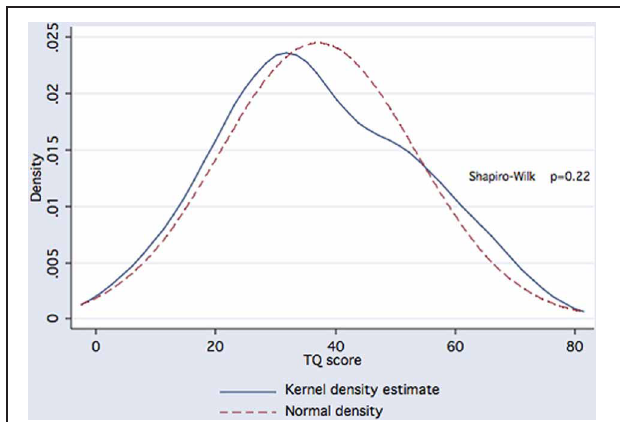
FIGURE 2 | Stratification of TQ scores by hearing loss and KCTD12 minor allele carrier status. Open circles indicate T178T carriers, filled circles indicate homozygous carriers of wildtype alleles. The degree of hearing loss is expressed as the binaural pure tone average involving air